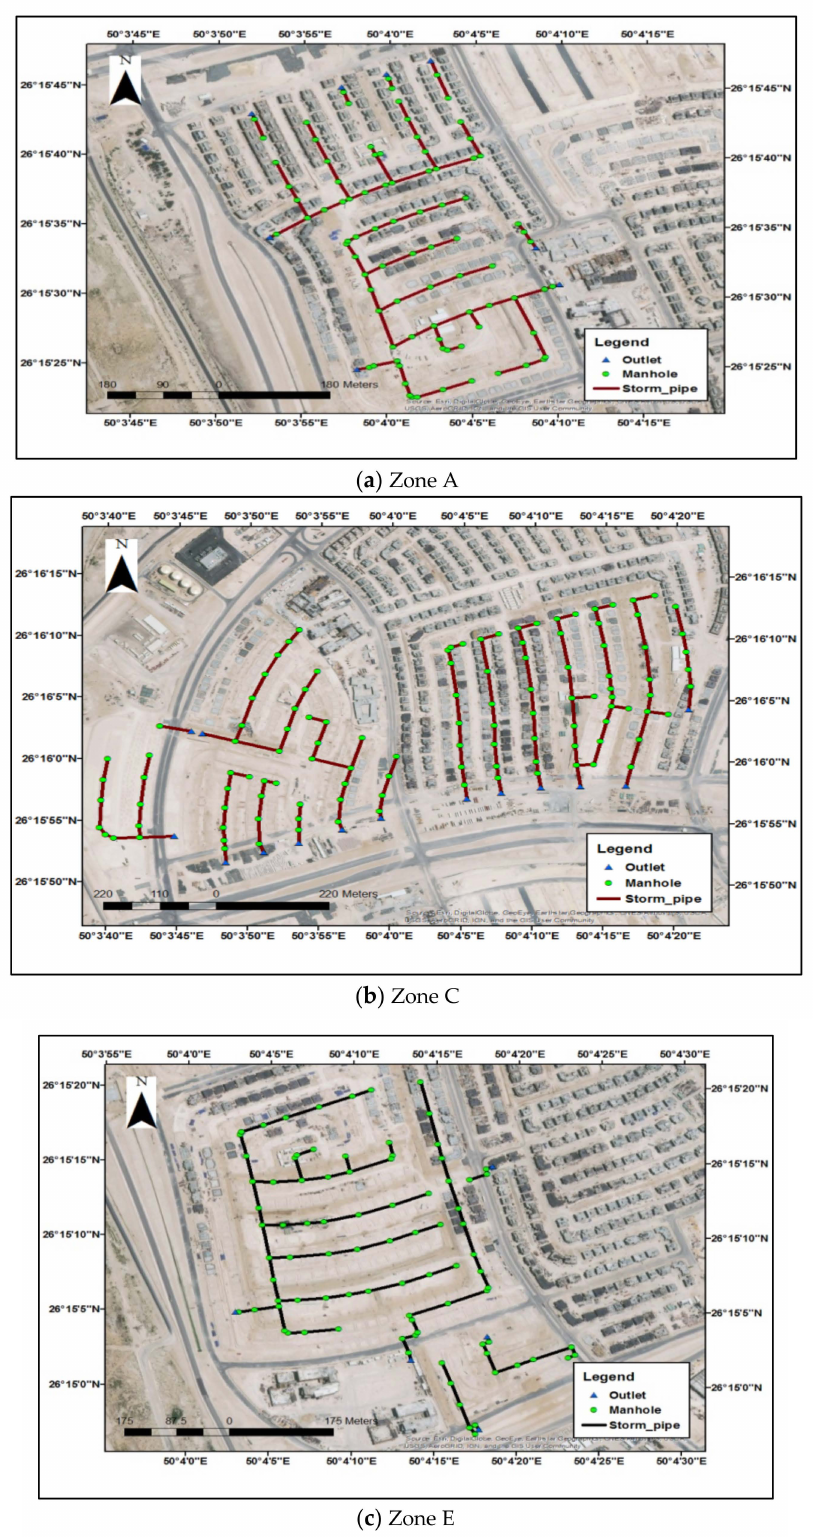
Figure 3. Storm water drainage system layout of zones A ( a ), C ( b ) and E ( c